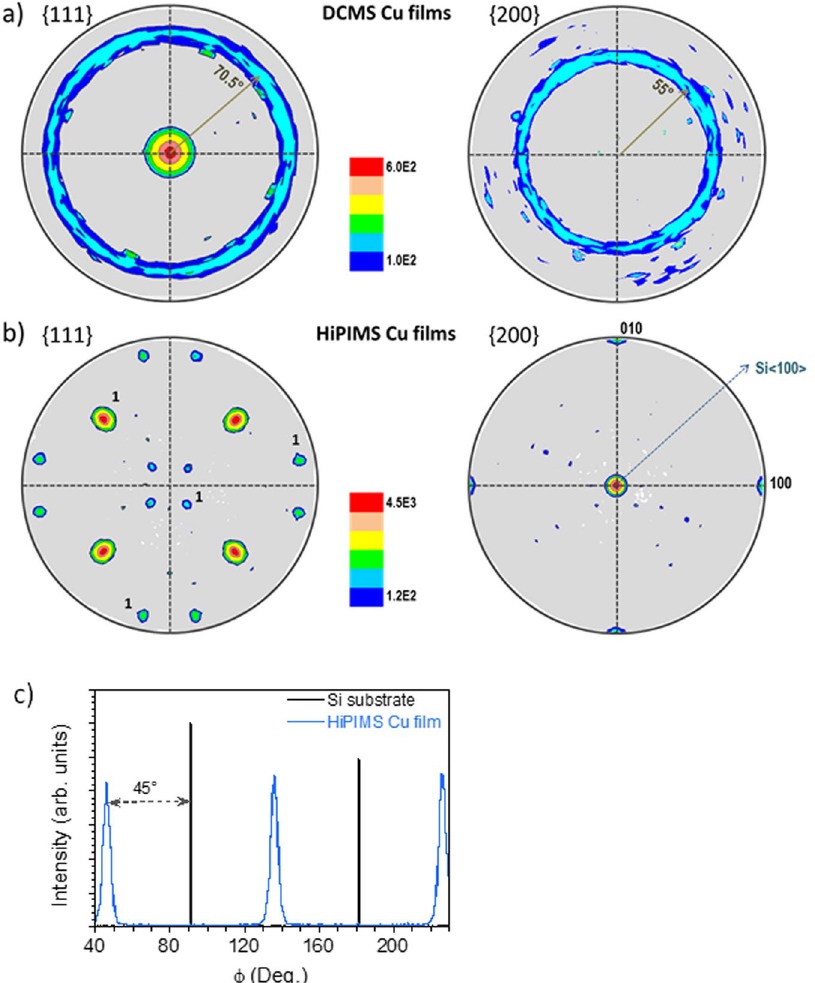
Figure 2. {111} and {200} XRD pole figures of Cu films grown at − 130 V bias. ( a ) DCMS film and ( b ) HiPIMS film (both ~150 nm thick). Label 1 denotes poles corresponding to one of the four twin sets associated with Cu {111} planes. ( c ) Phi-scans of the 111 intensity variation for both HiPIMS Cu film at − 130 V and Si substrate, recorded at ψ =